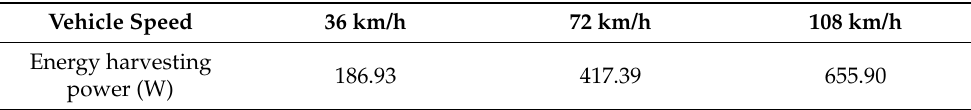
Figure 10. The energy harvesting power of the HIIRS-equipped half-vehicle when driven at various speeds on Class-C road. Table 7. Energy harvesting